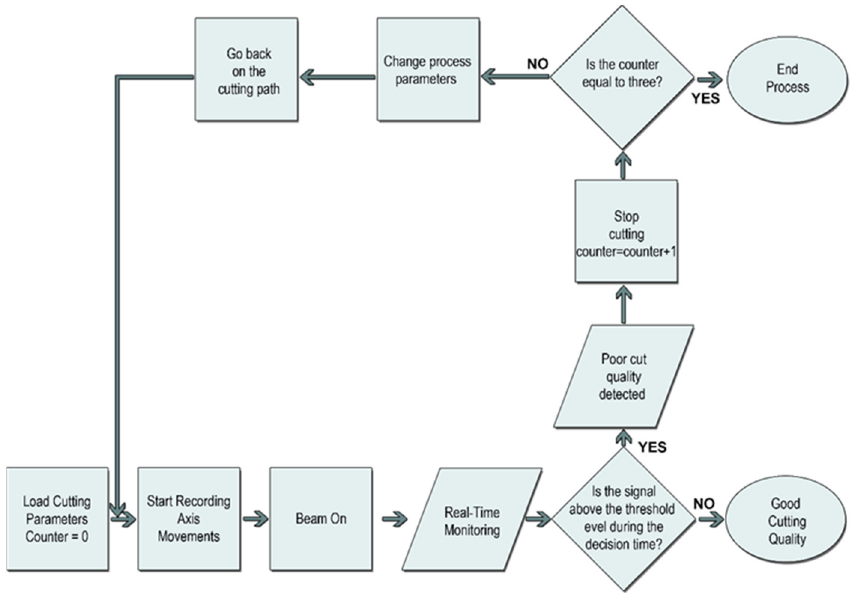
Figure 4. Cutting monitoring algorithm in high-power fiber laser systems.